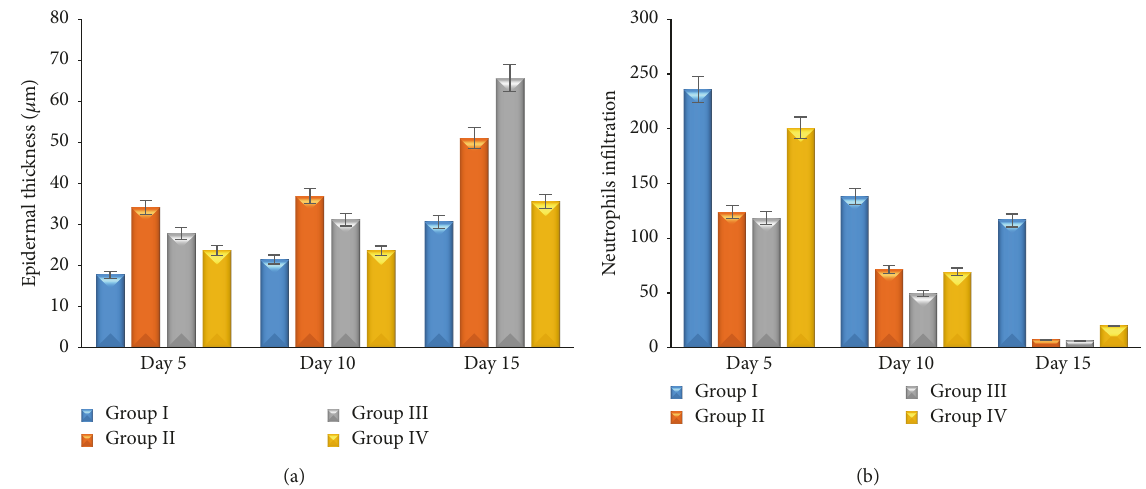
Figure 2: The average thickness of epidermis (a); the average number of neutrophils infiltration (b) on skin wound. 00.511.522.533.5